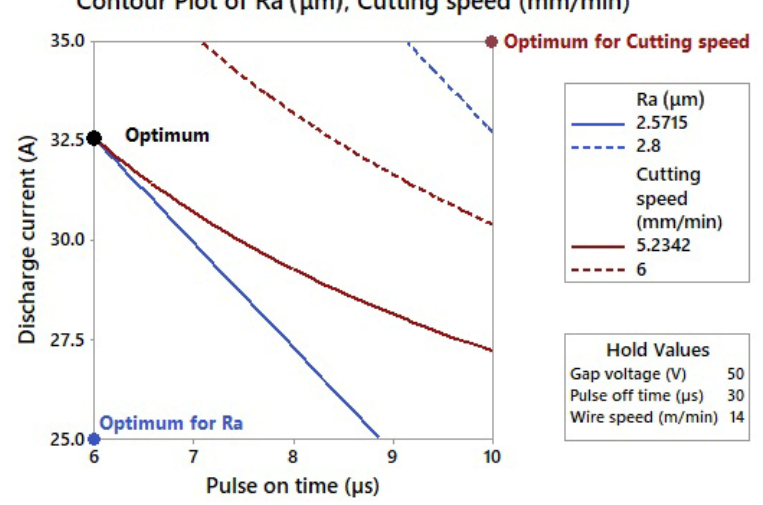
Figure 4. A multi-criteria Figure 4. A multi ‐ criteria optimization.